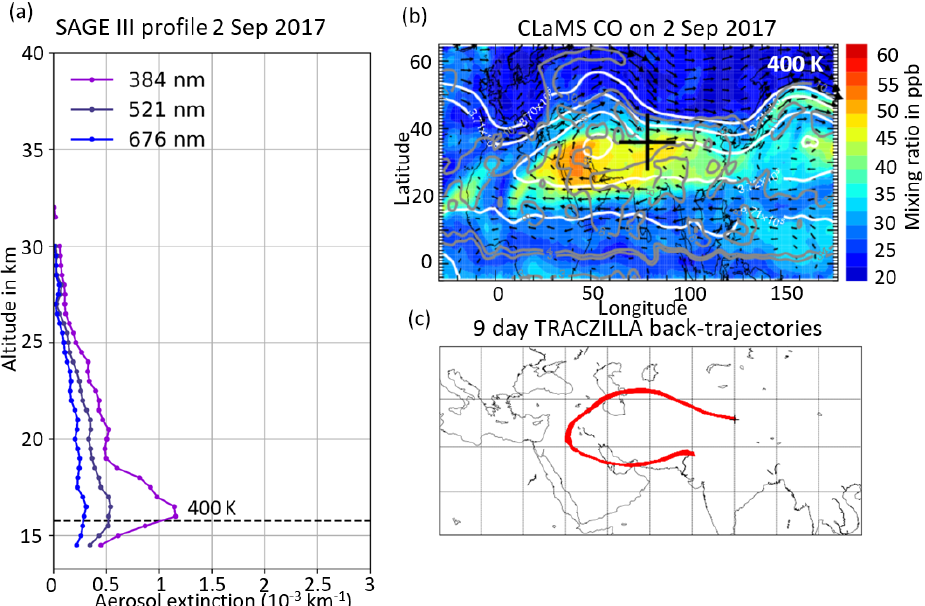
Figure B3. ATAL signal in the Asian region without fire influence: (a) and (b) as in Figs. 5, B1 and B1 for the profile measured on 2 September 2017 at 35.96 ◦ N and 80.04 ◦ E. (c) 9d TRACZILLA kinematic back-trajectories from the peak position in (a) at